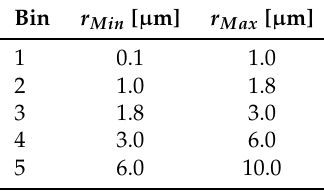
Table 6. Minimum and maximum radius of the five size bins that describe the dust size